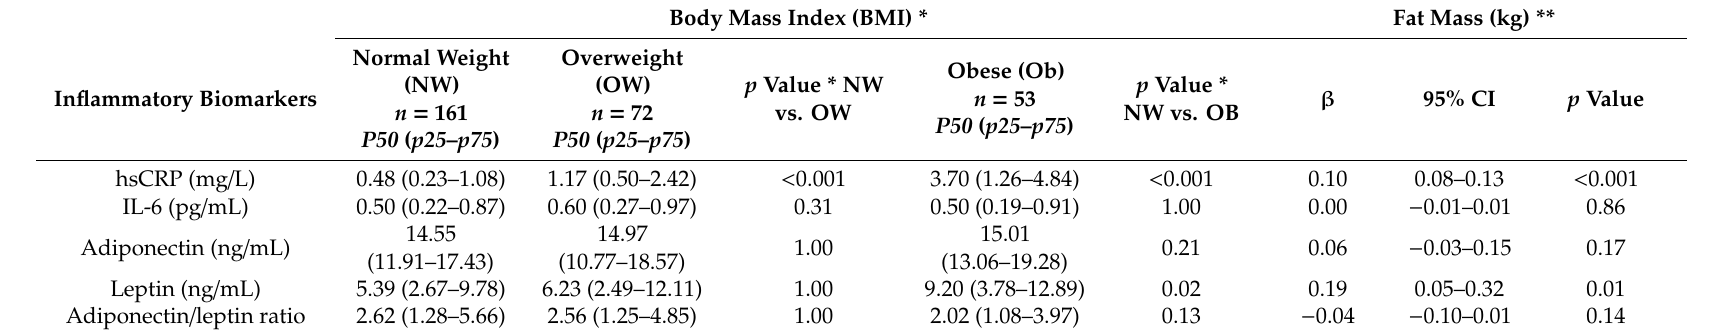
Table 2. Serum concentrations of inflammatory biomarkers at 11 years by BMI and Fat